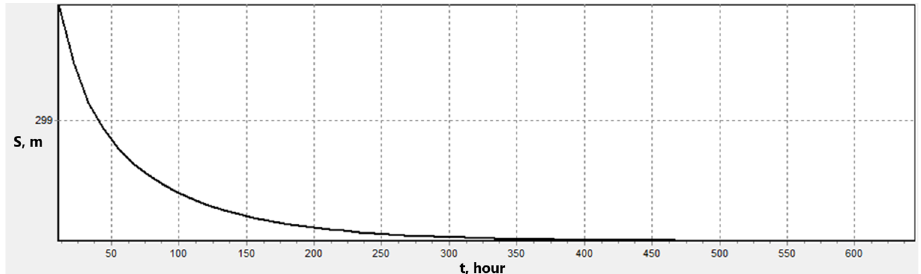
Figure 4. Graph of the fluid level lowering in the reservoir, m.